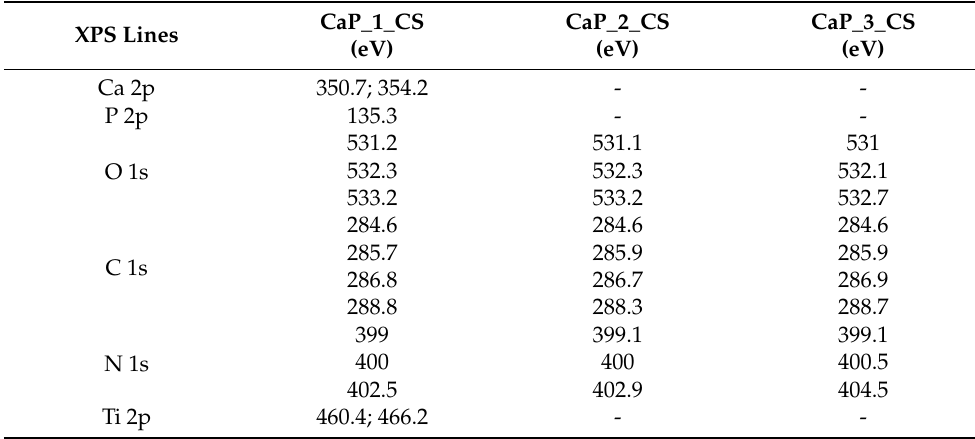
Table 2. XPS binding energies (eV) for the CaP_CS coatings.